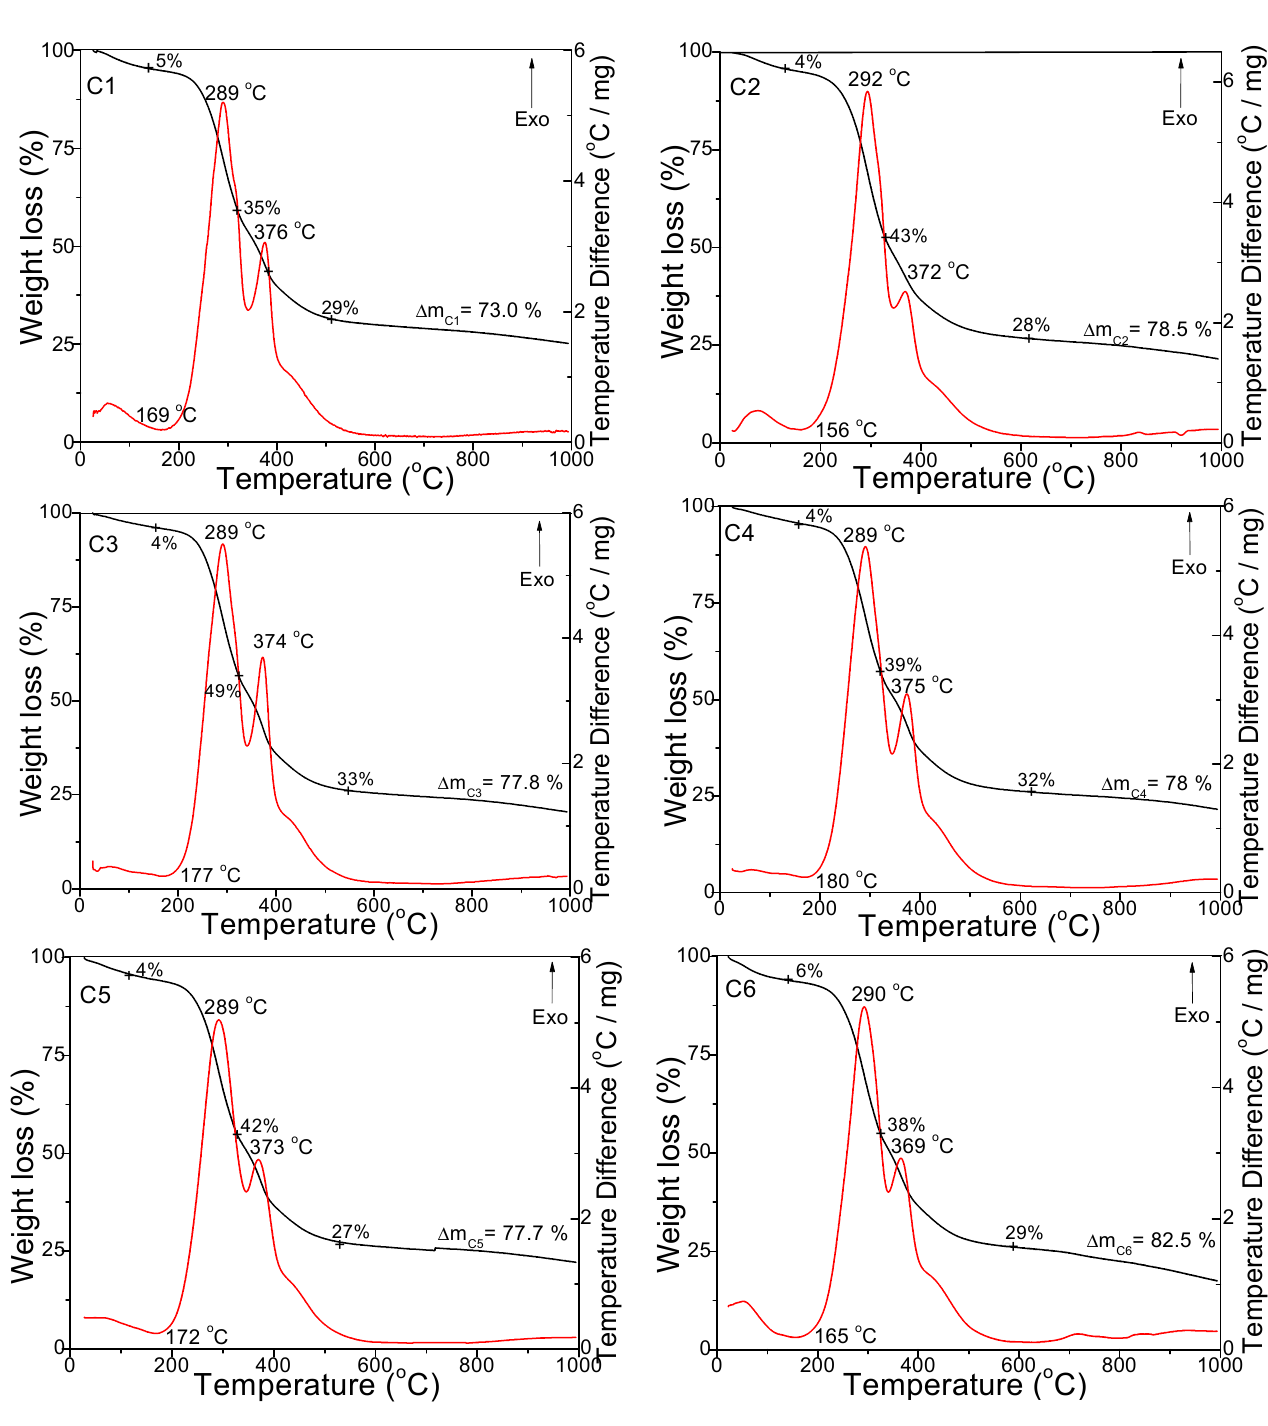
Figure 2. TG (black line) and DTA (red line) curves of the coffee samples under argon atmosphere. Hierarchical cluster analysis through heatmapping (Figure 4) was conducted to find the inter-connectivity and closeness of the studied coffee samples and individual volatile organic compounds. Heatmap representation clearly showed differentiation with respect to the volatile aromatic-compound profiles of the samples. At the same time, the hierar- chical clustering indicated that C1 and C6 samples (dark-roasted Arabica varieties) were distributed separately and fell aside from the heatmap compared with the other samples (medium-roasted Arabica, Robusta, and their pounds, respectively. Total ion chromatograms of the analyzed samples are provided in Figure 3. The odor characteristics were compared with those presented in [32].